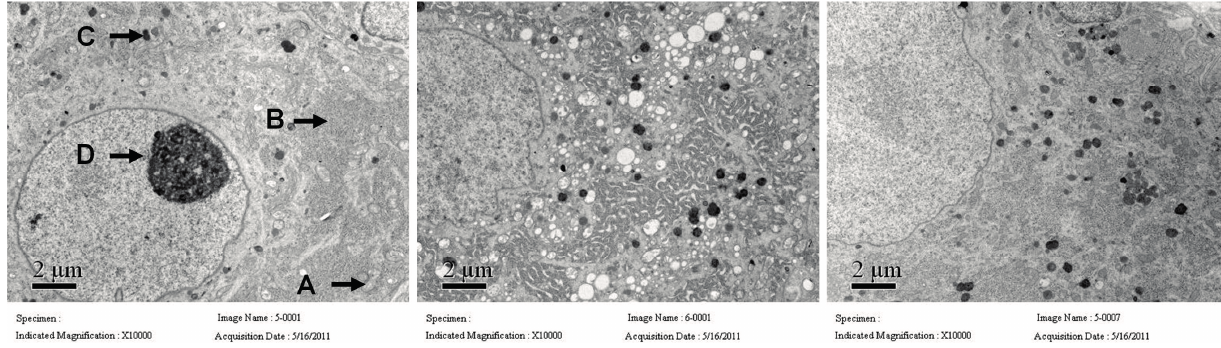
Figure 5. Transmission electron microscopy of major pelvic nerve ganglion in normal, DM placebo (untreated) and ICA II-treated group rat corpus cavernosum (A: mitochondria, B: mitochondria, C: mitochondria, D: mitochondria). The rough endoplasmic reticulum is highly dilated with degranulation, the mitochondria are swollen with vacuolization; the crista mitochondrion dissolved and fragmented, and the lysosome decreased in the DM placebo group. The microstructure was significantly improved in the ICA II-treated diabetic group compared to the DM placebo